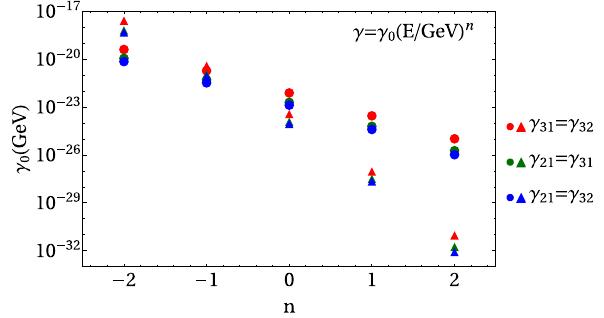
Fig. 6 95% CL bounds on the decoherence parameters γ 0 , for NO, as a (discrete) function of the power-law index n for the Atmospheric limit (red), Solar limit I (green) and Solar limit II (blue). The solid circles (triangles) correspond to the DeepCore (IceCube) analysis